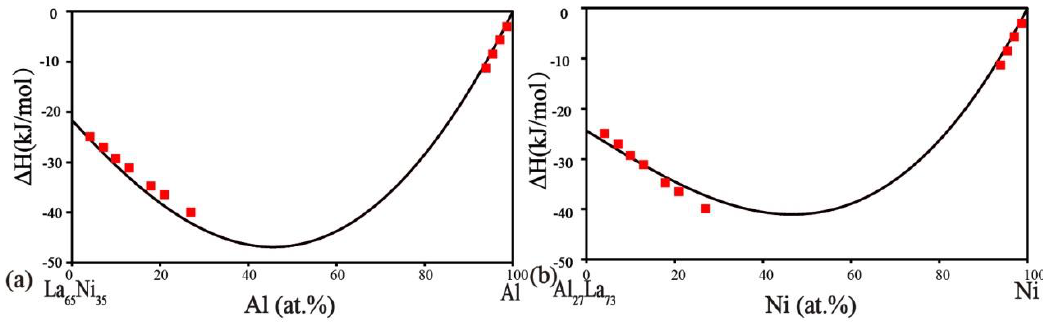
Figure 11. Calculated mixing enthalpies of the Ni – Al – La ternary system at 800 °C compared with experimental data [49], ( a ) (La 65 Ni 35 ) 1 − x Al x section; ( b ) (Al 27 La 73 ) 1 − x Ni x section.